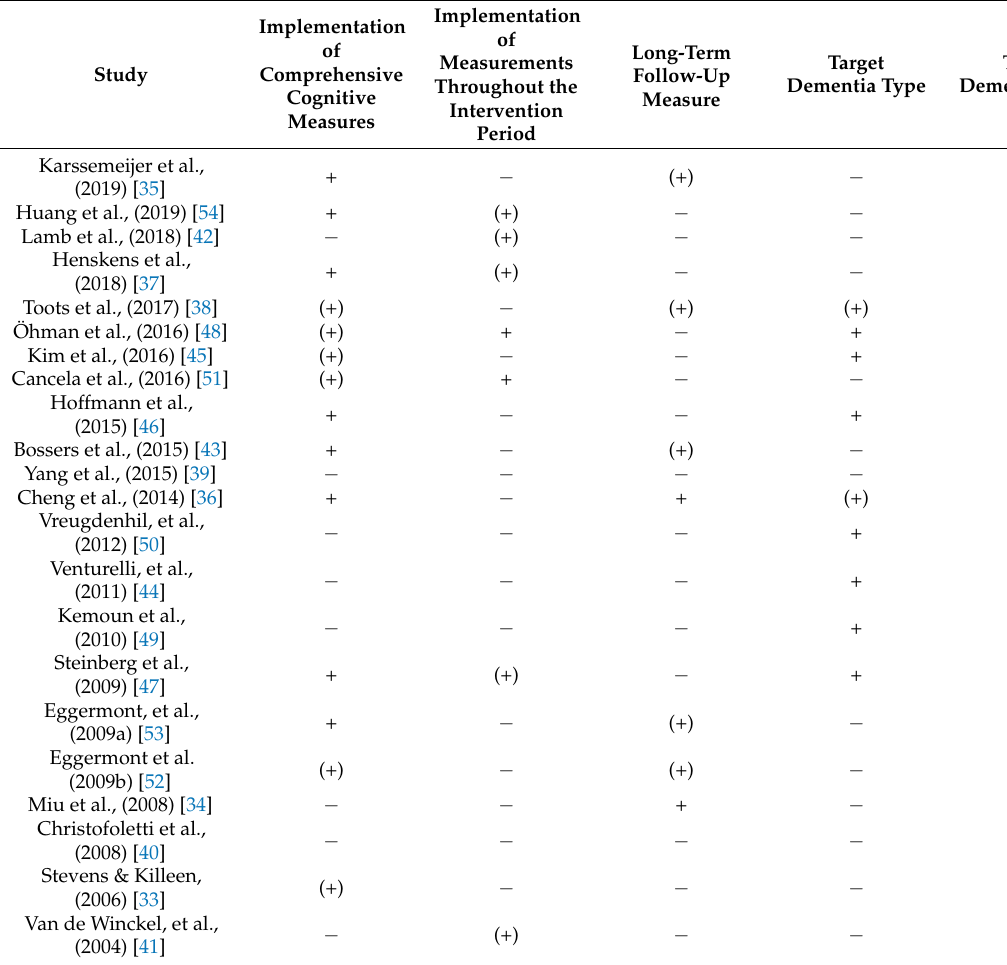
Table 4. Inclusion of methodological recommendations